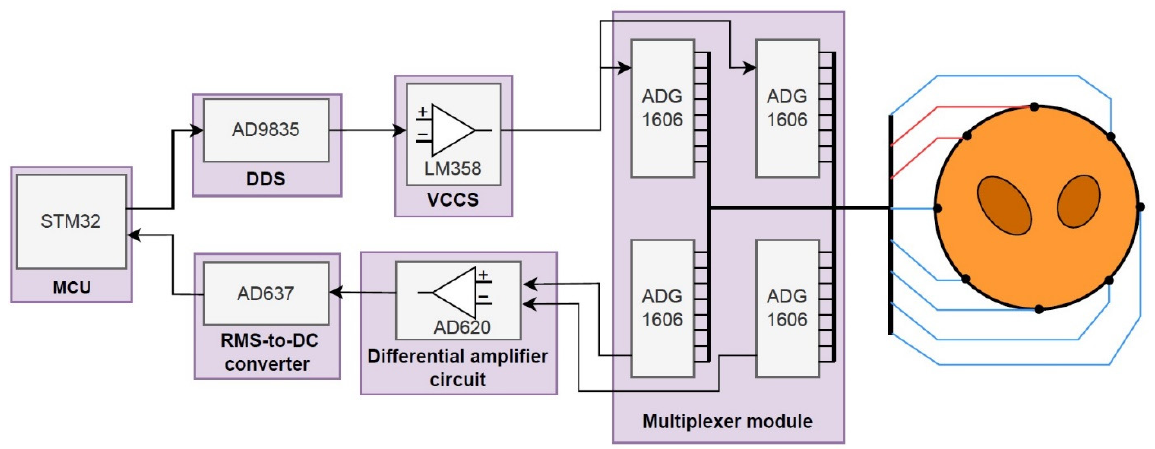
Figure 5. Overall architecture diagram of system hardware. The red line in the figure represents the input terminal of the excitation current, and the blue line represents the measurement terminal of the induced voltage.